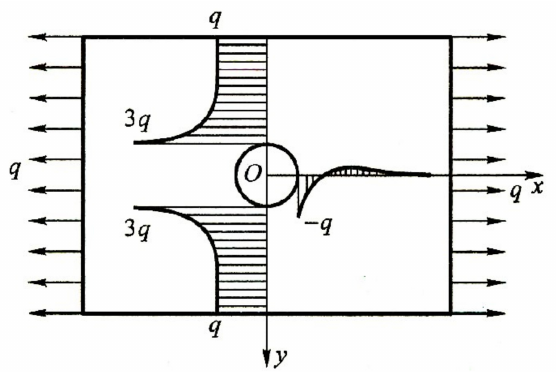
Figure 10. Schematic diagram of hole edge stress of round hole.